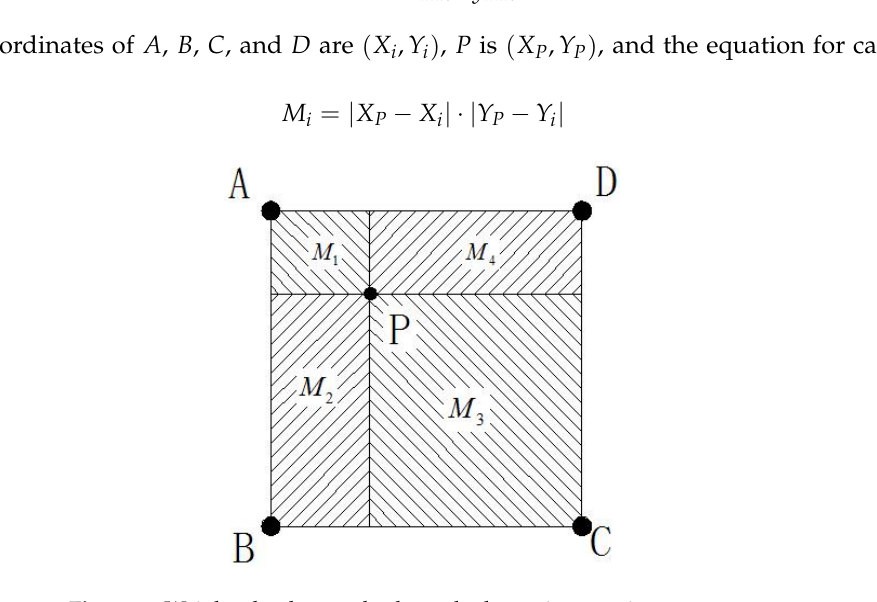
Figure 2. Weighted value method to calculate microscopic temperature.